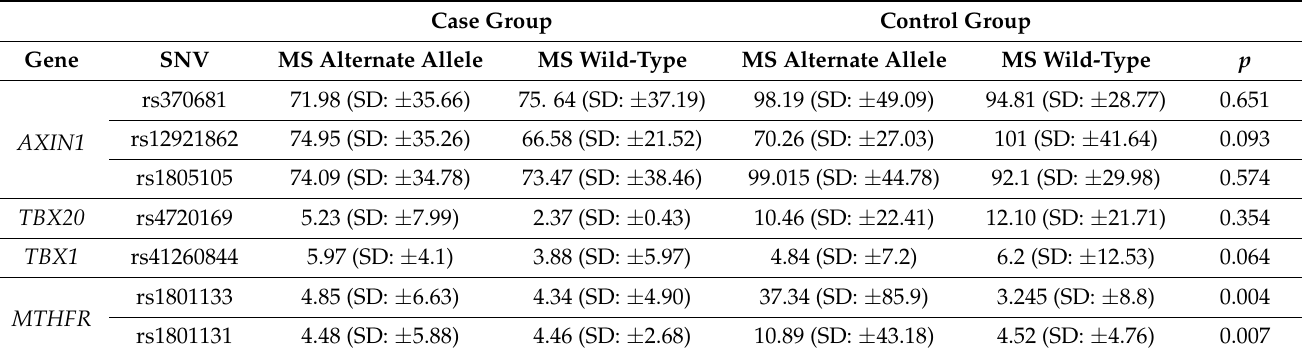
Table 5. Comparison of MS between the four subgroups: case group with alternate allele, case group with wild-type allele, control group with alternate allele, and control group with wild-type allele. Case